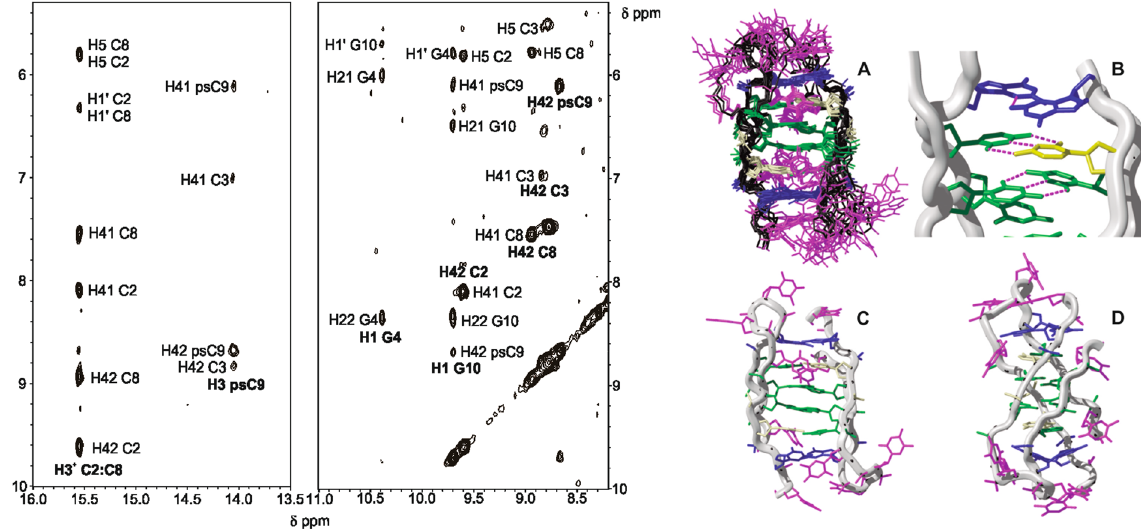
Figure 4. Assignment of exchangeable protons and solution dimeric structure of CC9 . Left: Imino and amino exchangeable protons region of NOESY spectrum (250 ms) of CC9 . H 2 O/D 2 O 90:10, 25 mM phosphate buffer pH 7, 100 mM NaCl, T = 5 °C, [oligonucleotide] = 0.8 mM. Right: ( A ) Structural ensemble. ( B ) Detail of C:C + , C:psC and G:G stack. ( C , D) Front and lateral view of a representative structure. Cytosines are shown in green, psC in yellow, guanines in blue and thymines in